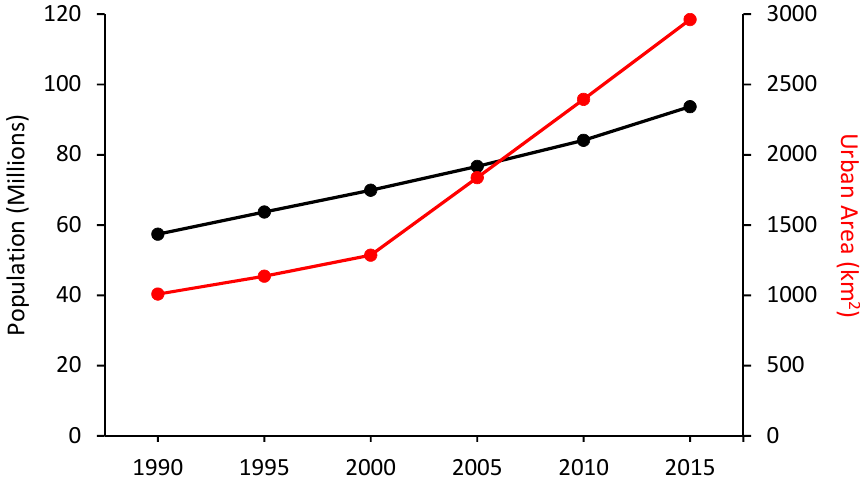
Figure 2. Urban land use/land cover (LULC) and population growth in Egypt [1].